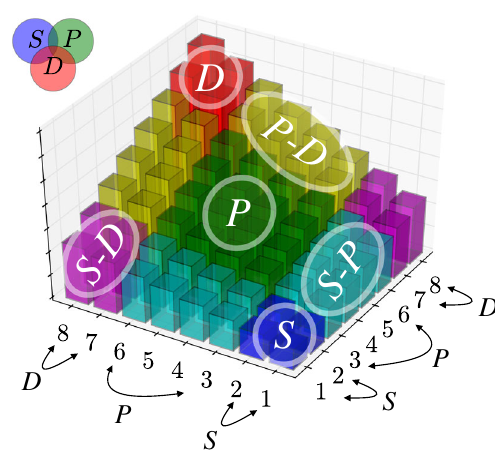
Fig. 6 Legend for OAMD plots with annotations